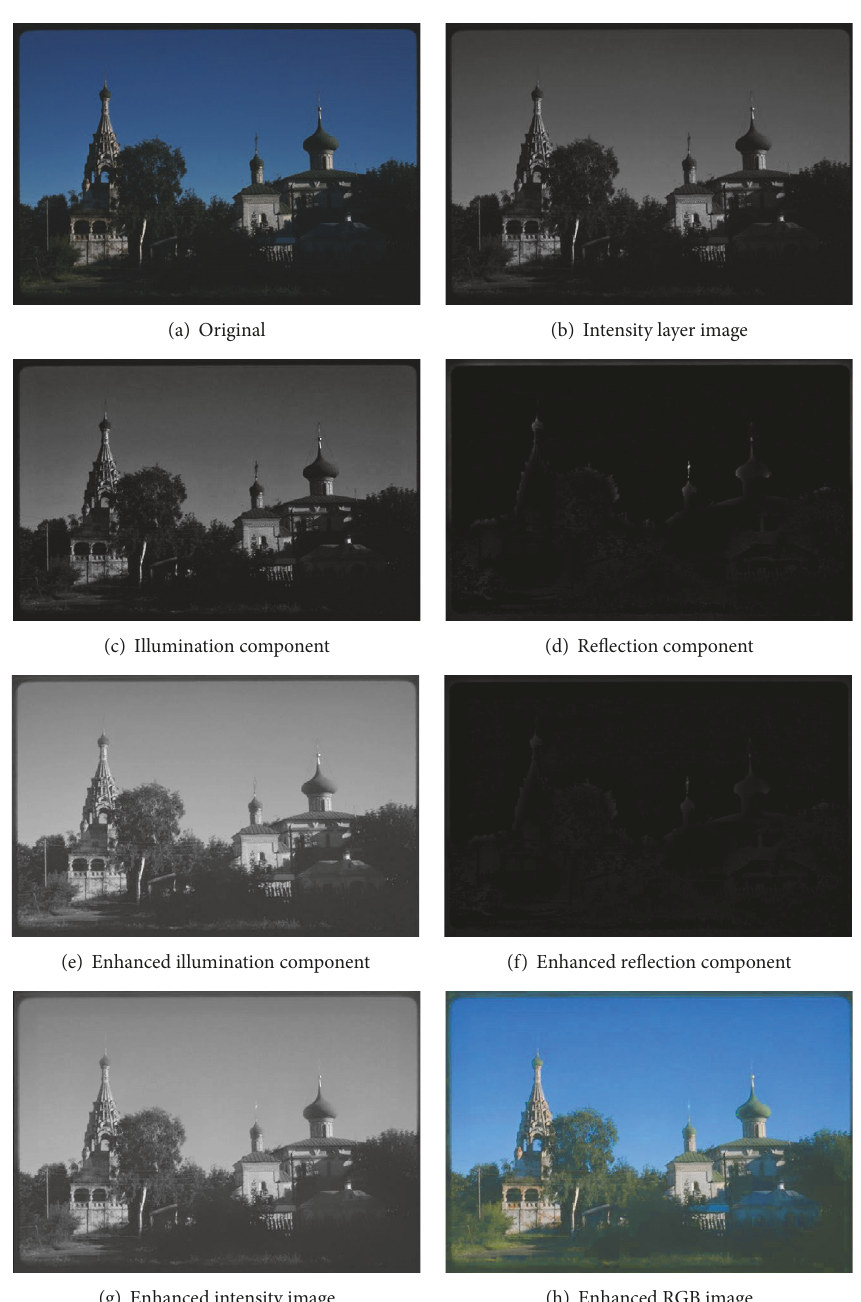
Figure 9: The proposed procedure of low-light